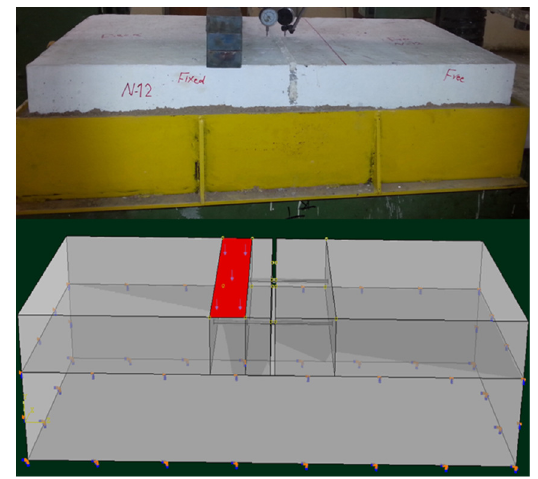
Fig. 13. 3-D General Geometry of the Concrete Pavement in